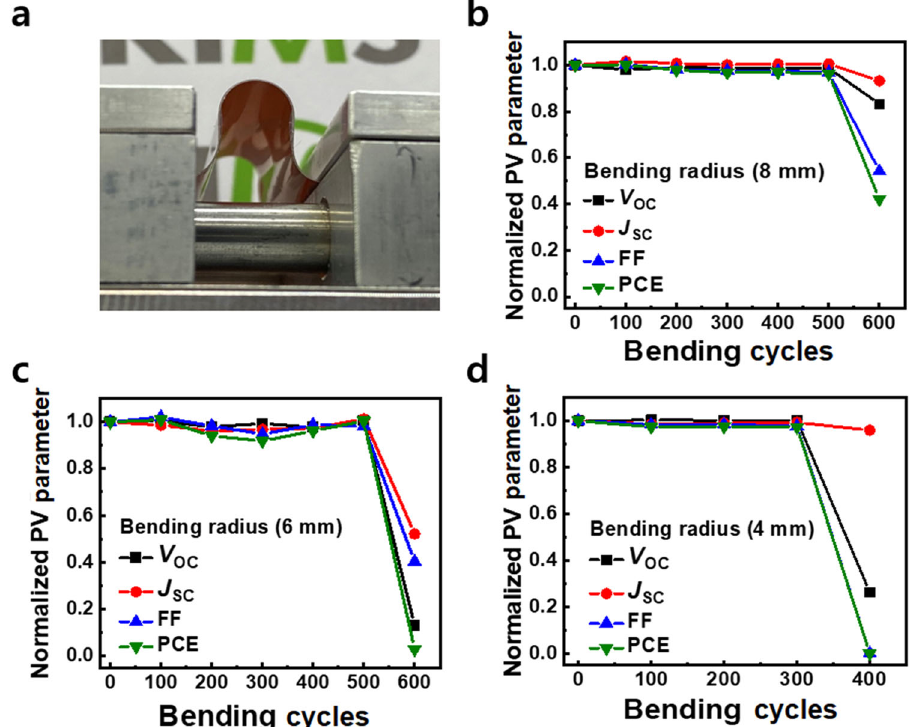
Fig. 8 Mechanical durability of fl exible TSCs. a Image showing setup used for repeated bending of fl exible TSCs. Effects of repeated bending at bending radii of b 8, c 6, and d 4 mm on normalized photovoltaic (PV) device parameters averaged over eight